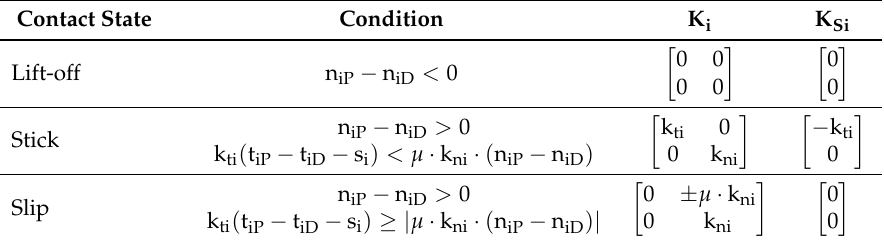
Table 1. Expression of the contact stiffness matrix depending on the contact state. Contact State